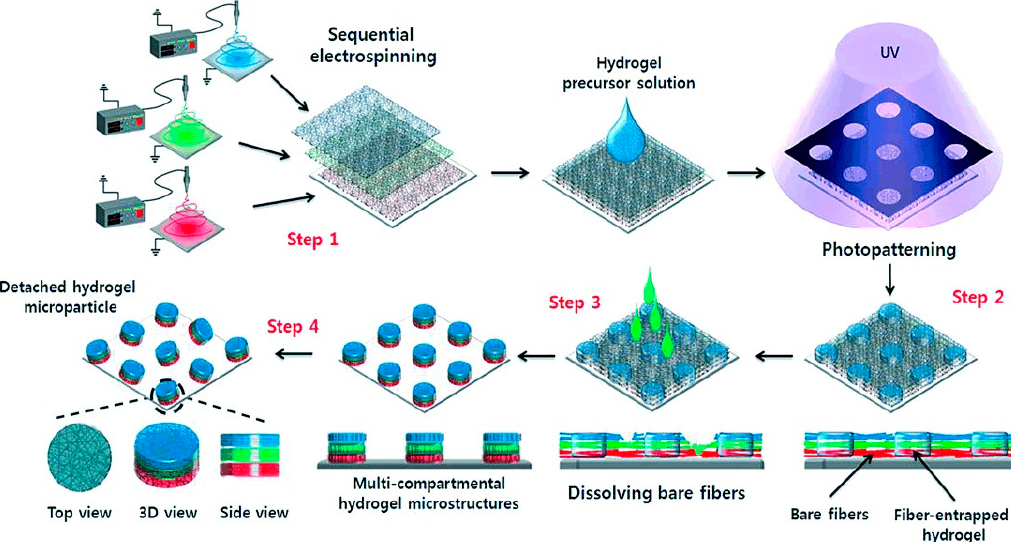
Figure 4. Schematic illustration of preparing multi-compartmental hydrogel microparticles by using sequential electrospinning and photopatterning. Reprinted from [12] with permission.